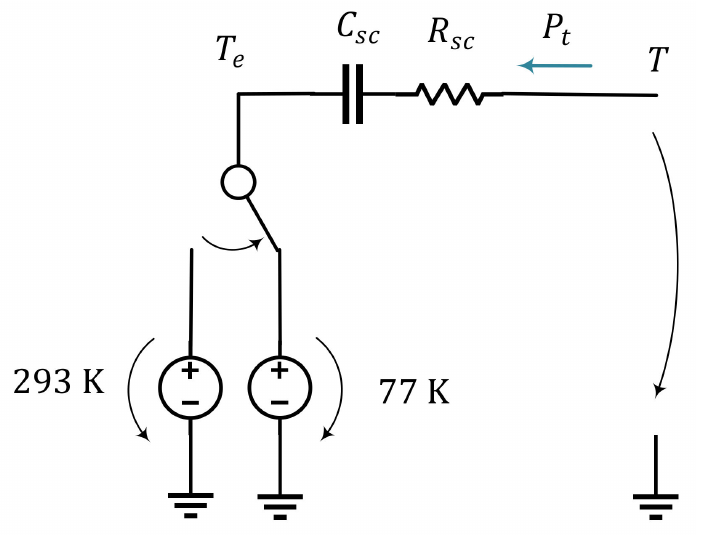
Figure 11. The thermal circuit that models the YBCO stepped transition from room to LN 2